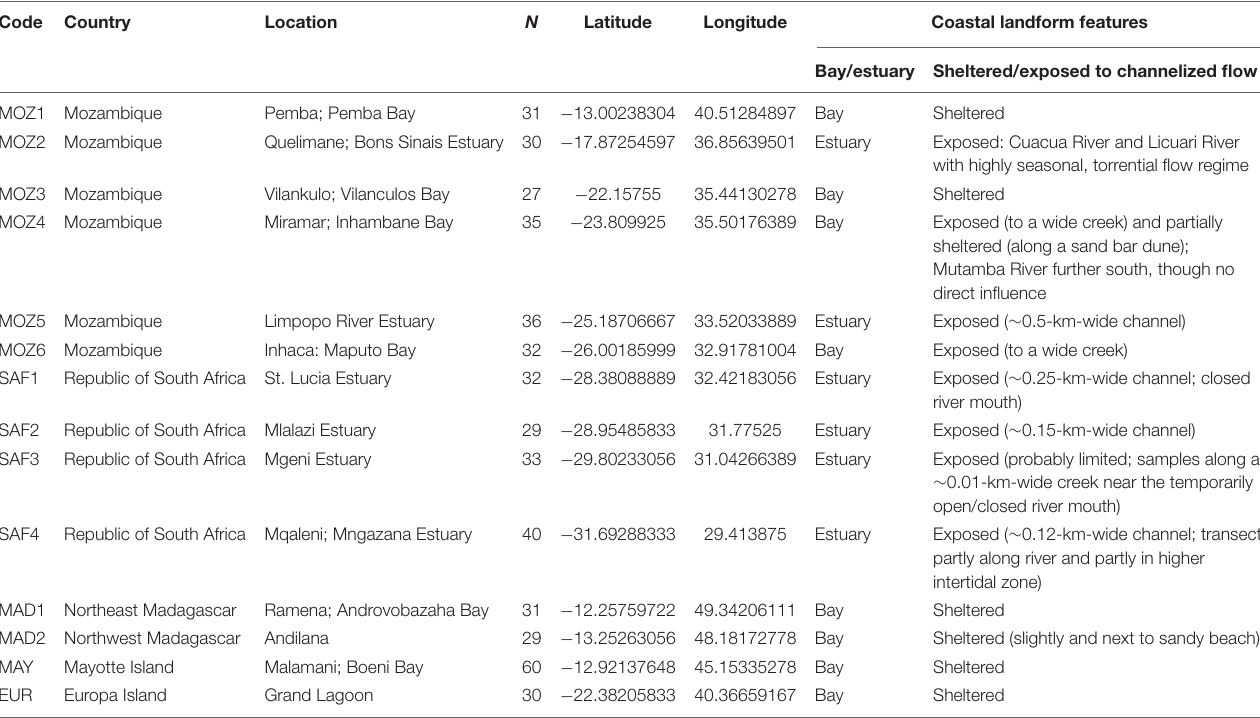
TABLE 1 | Location details and coastal landform features of 14 Avicennia marina populations in the Western Indian Ocean region, considered for fine-scale genetic